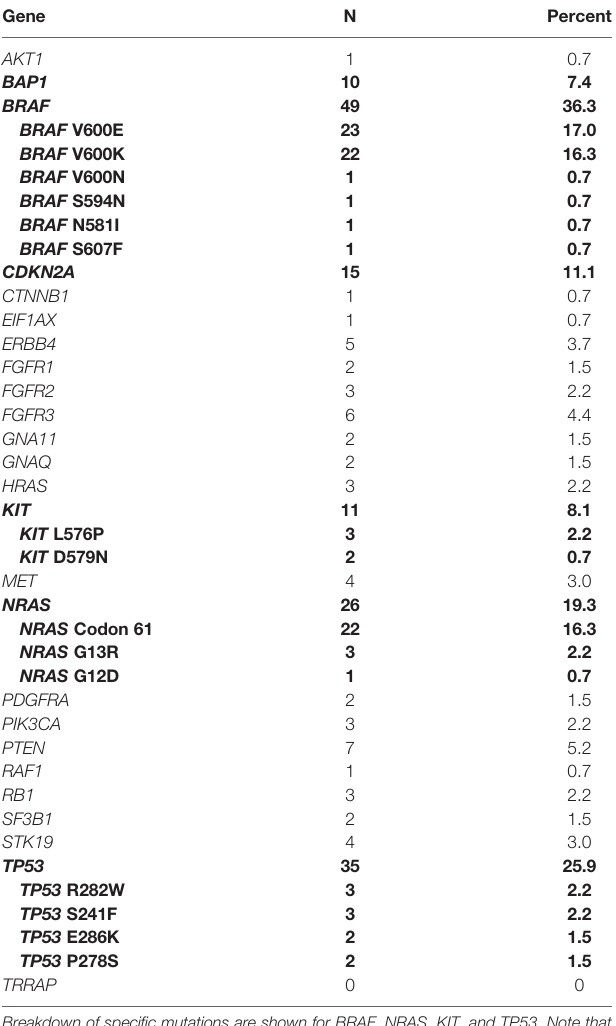
TABLE 3 | Mutations found in melanomas of 135 patients by next-generation sequencing. Gene N Percent